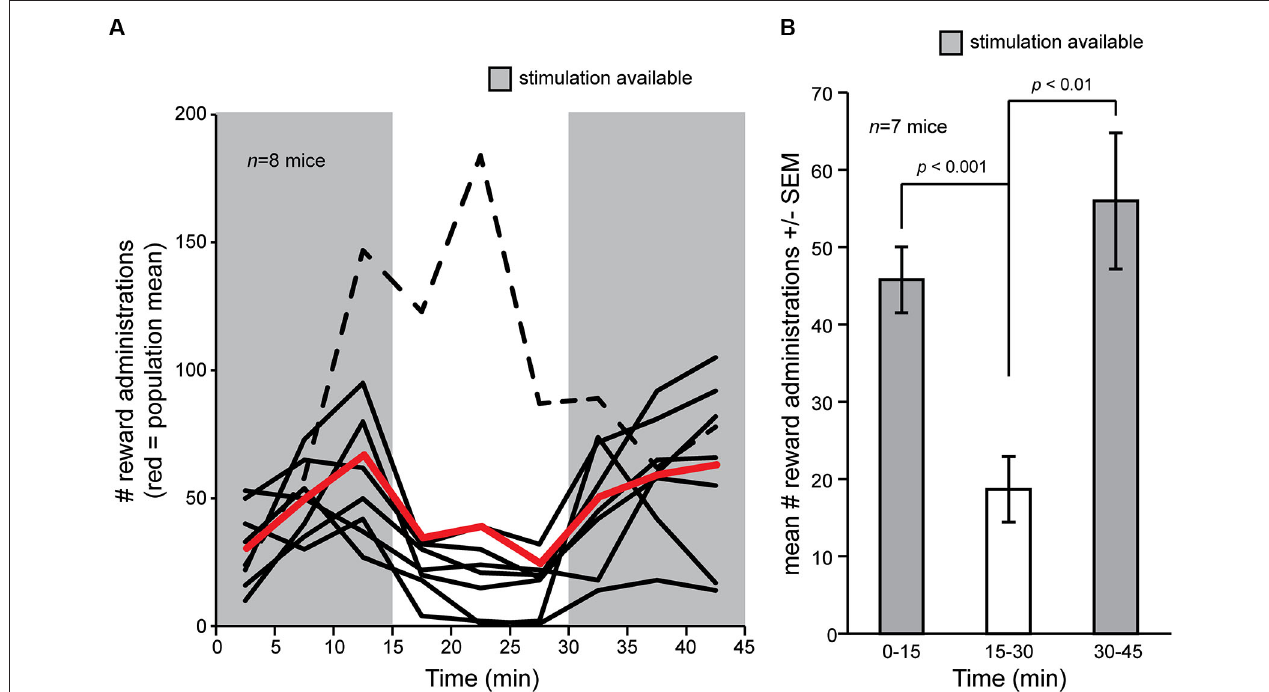
who strikingly increased the number of touch pad presses even though stimulation was not delivered (black dashed line). Red line = population mean, including outlier (dashed line). (B) Mean number of reward administrations from (A) in each 15 min block in the self-stimulation task, but with the outlier (dashed line) subject removed from the mean. p -values = ANOVA followed by Fisher’s